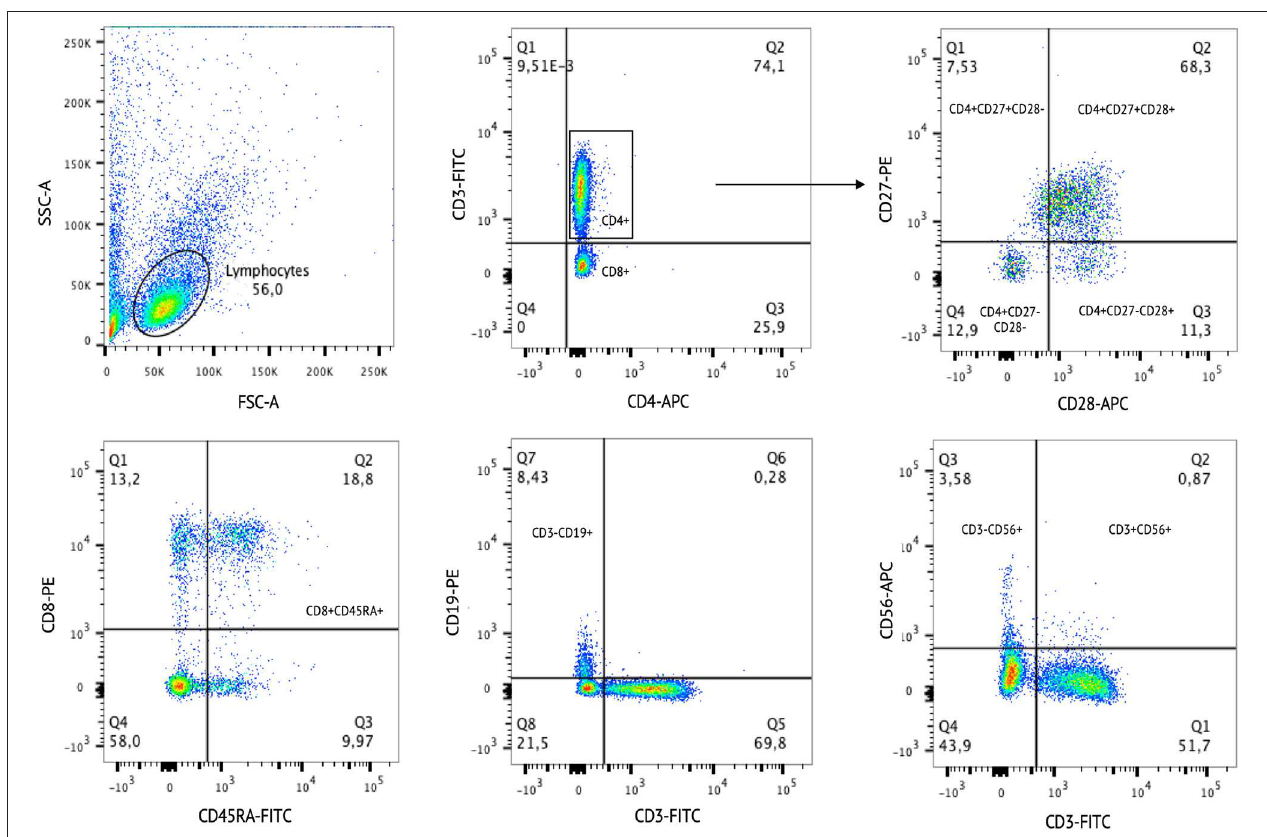
FIGURE 4 | Example of cell gating strategy. The Side Scatter parameter (SSC-A) is correlated with cell granularity. The Forward Scatter parameter (FSC-A) is correlated with cell size. The SSC-A and FSC-A are used to select single cells out of the debris. After the cell populations were selected according to specific